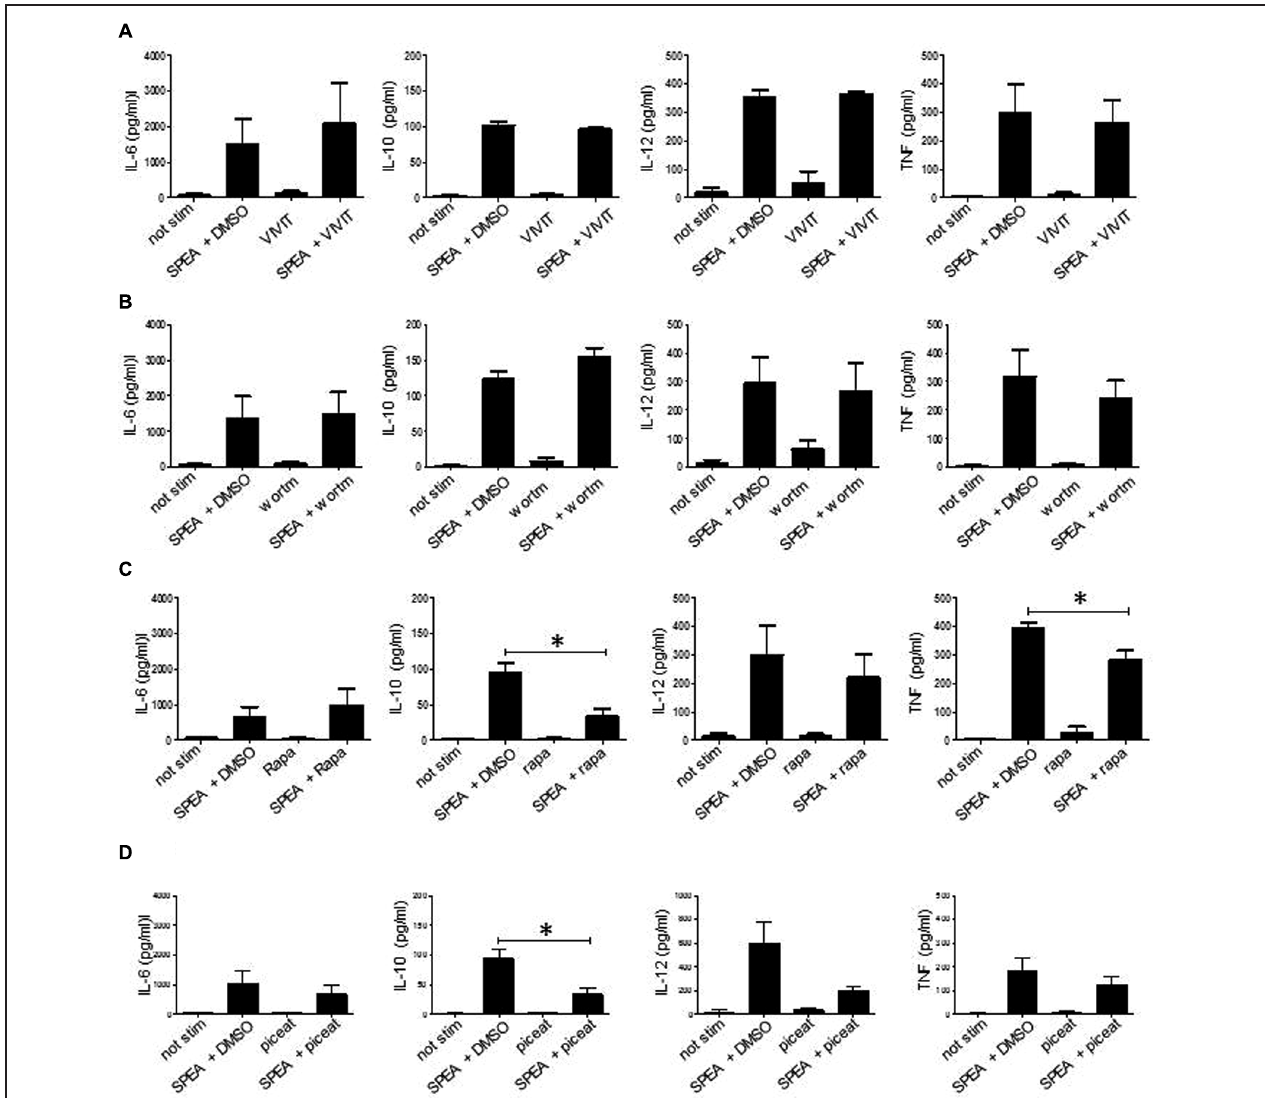
FIGURE 4 | Signaling pathways involved in SPEA- mediated activation of APC. CD14 + monocytes were stimulated with SPEA (100ng/ml) in the presence or absence of (A) VIVIT (1 M), (B) Wortmannin (50 nM), (C) rapamycin (50nM) and (D) piceatannol (50 μ M) or DMSO (equal volume to inhibitor) as solvent control. 24 h after stimulation supernatants were harvested and ELISAs were performed for IL-6, IL-10, IL-12p40 and TNF. Shown is the mean ± SD from 3 different donors, except VIVIT ( n = 2). Statistical analysis was performed using a Multiple Comparison of Means (Tukey Contrasts). Significance codes: 0 ‘ ∗∗∗ ’; 0.001 ‘ ∗∗ ’; 0.01 ‘ ∗